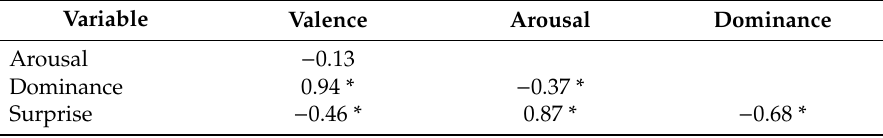
Table 3. Pearson correlations of valence, arousal, dominance, and surprise ratings. Variable Valence Arousal Dominance −